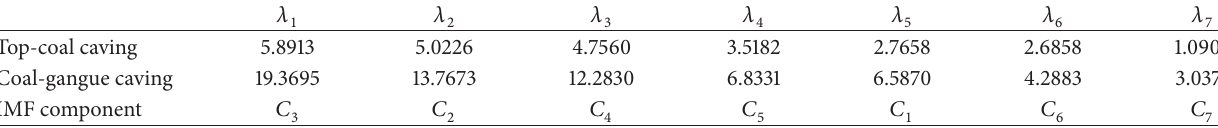
Table 1: Comparison of singular values of selected IMFs for each caving state.